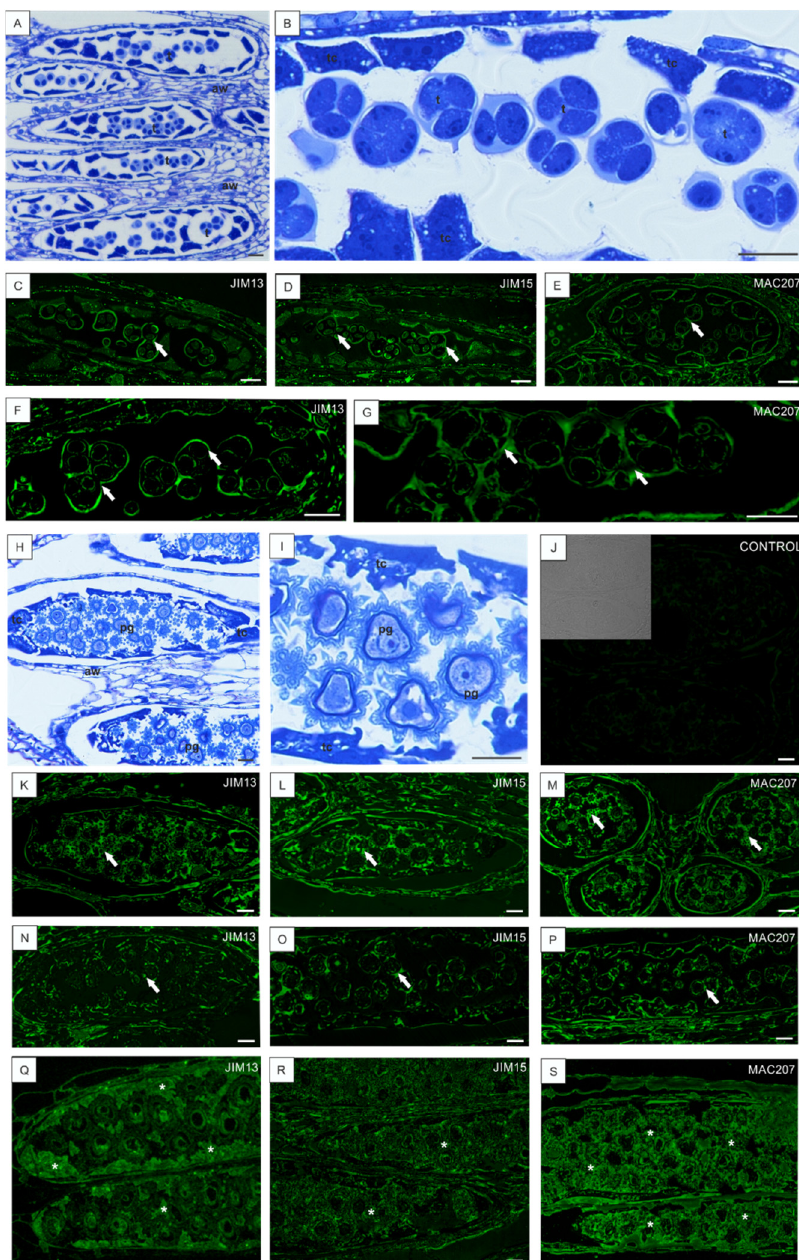
Figure 5. AGP localization in the B. perennis anther at the tetrad stage and with mature pollen grains developing at low temperature. Histology of anthers with tetrads of microspores ( A , B ). AGPs in walls around the microspores in the tetrad stage (arrows); reaction with JIM13 ( C ), JIM15 ( D ), and MAC207 ( E ). Higher magnification of tetrad microspores (arrows) labeled with JIM13 ( F ) and MAC207 ( G ). Histology of anthers filled by numerous mature pollen grains ( H ). Magnification of pollen grains with a developed exine layer ( I ). Control reaction to immunolabeling ( J ). Sections of anthers with pollen grains (arrows) and visible tapetum cells labeled by JIM13 ( K ), JIM15 ( L ), and MAC207 ( M ). Labeling of mature pollen grains (arrows) with JIM13 ( N ), JIM15 ( O ), and MAC207 ( P ). Immunofluorescence reactions of remnants of tapetum cells (asterisks) after reaction with JIM13 ( Q ), JIM15 ( R ), and MAC207 ( S ). Toluidine blue staining: ( A , B , H , I ). Immunolabeling: ( C – G , J – S